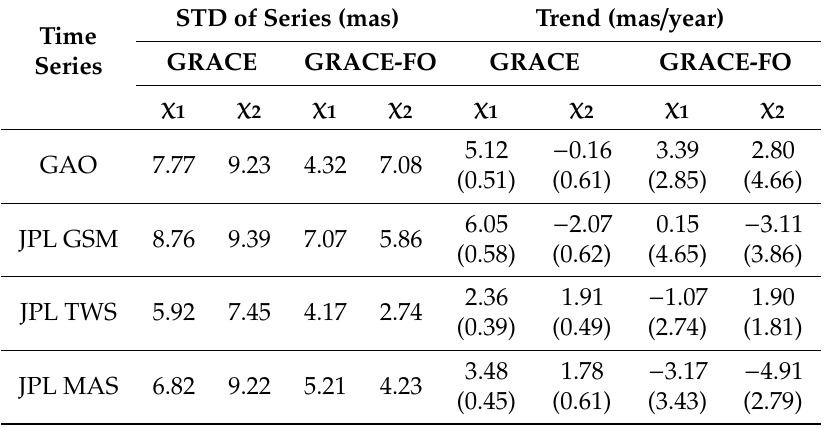
Figure 14. Time series of ( a ) χ 1 and ( b ) χ 2 components of GAO and HAM / CAM computed from GRACE and GRACE-FO monthly solutions. Level-2 data (GSM) and Level-3 data (TWS and MAS) are considered. All GRACE- and GRACE-FO-based HAM / CAM series were computed using data from JPL. Table 3. Standard deviation (STD) of GAO and HAM / CAM (from GSM, TWS, and MAS) series and trends in GAO and HAM / CAM (from GSM, TWS, and MAS) series. All GRACE- and GRACE-FO-based HAM / CAM series were computed using data from JPL. Trend errors are given in